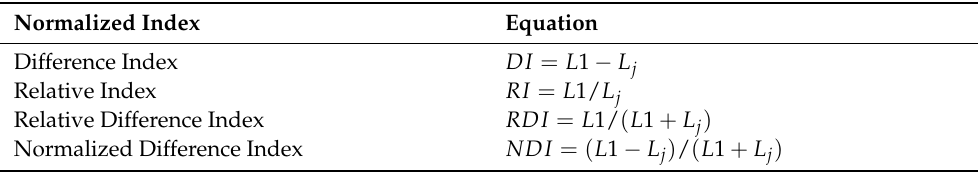
Table 3. Equations of normalized indices calculated for different proximal optical sensors. L1 is the latest fully expanded leaf. L j is the leaf position and varies from 2 to